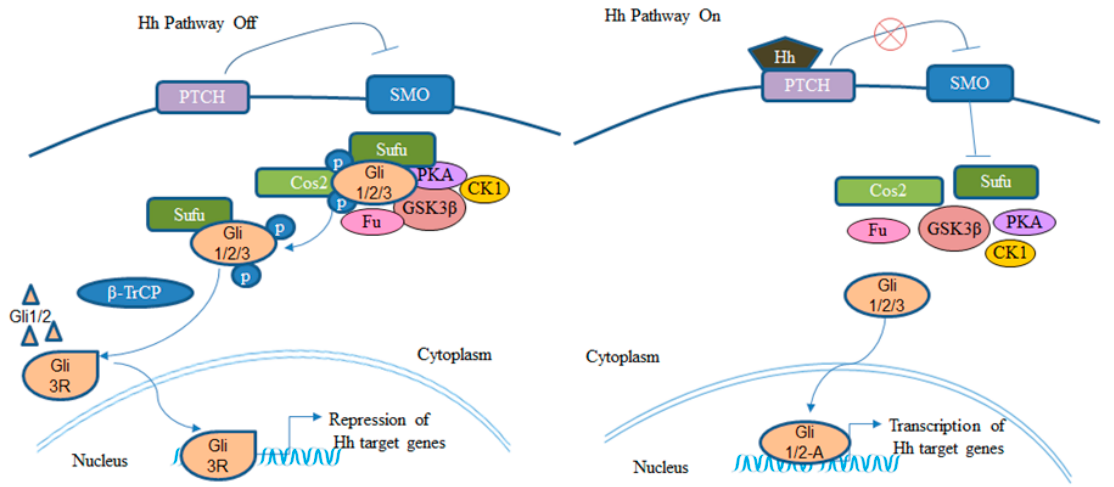
Figure 1. The canonical Hh signaling pathway. GLI 3R; GLI 3 repressor; GLI 1/2-A; GLI 1 and 2 activators [34,42].